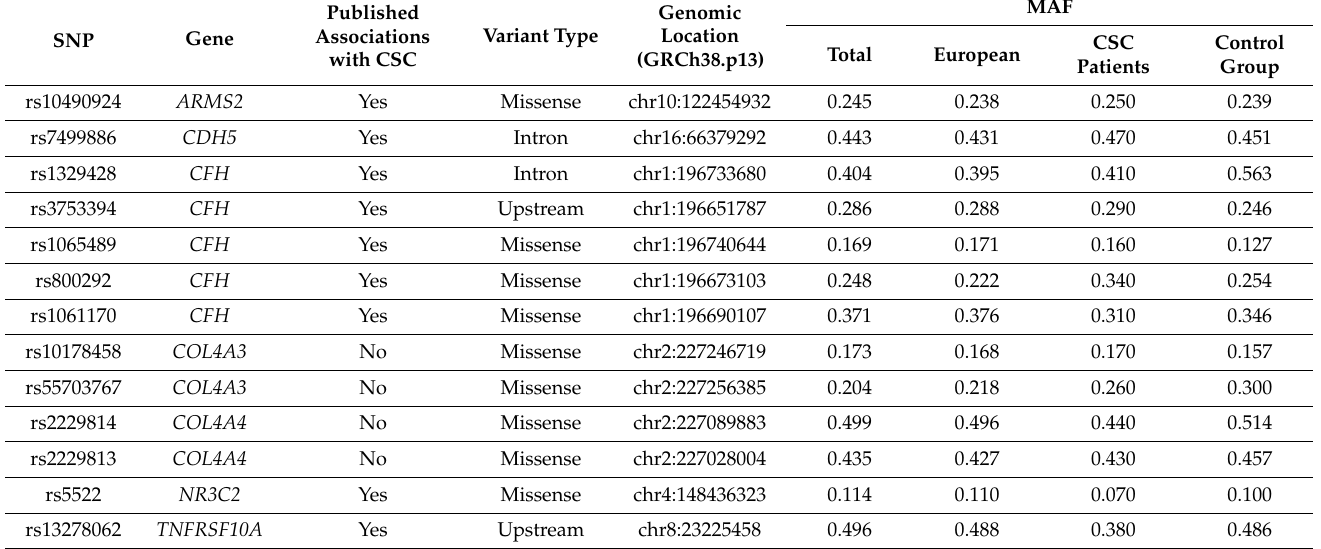
Table 1. Description of the investigated single-nucleotide polymorphisms (SNPs) with minor frequen- cies. MAF: minor allelic frequency; Total: global frequencies across all populations as obtained from dbSNP database (https://www.ncbi.nlm.nih.gov/snp/ (accessed on the 25 October 2021); European: European frequencies as obtained from the dbSNP database; CSC: central serous